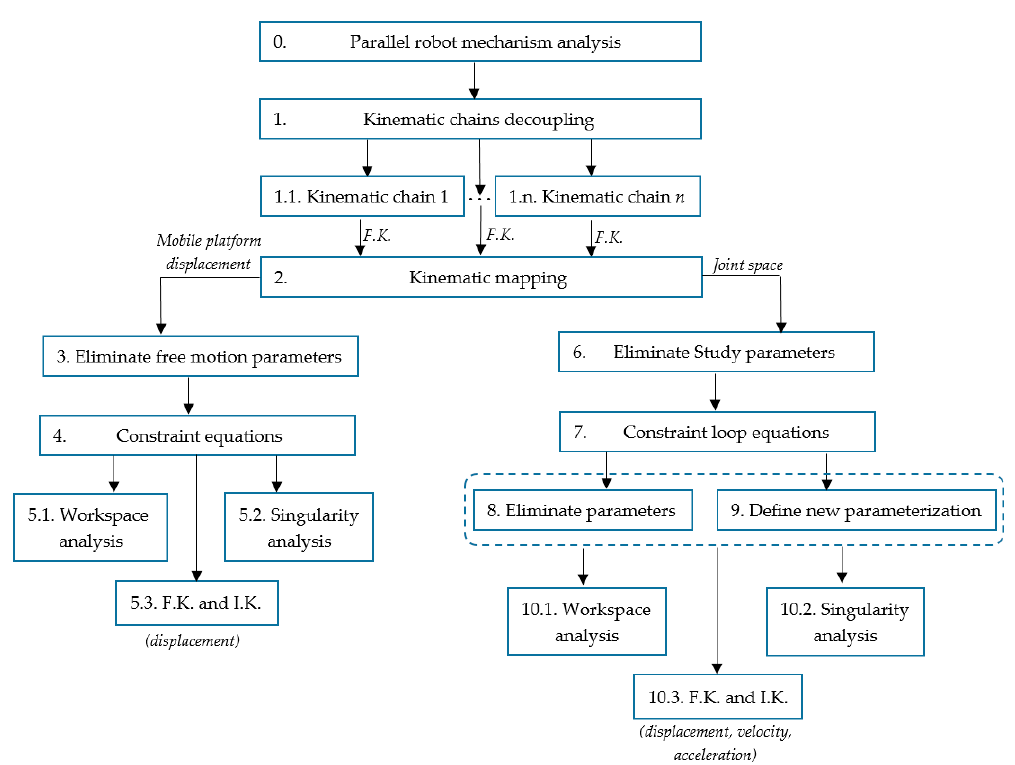
Figure 1. Stepwise algorithm for the joint-space description of a parallel robot.